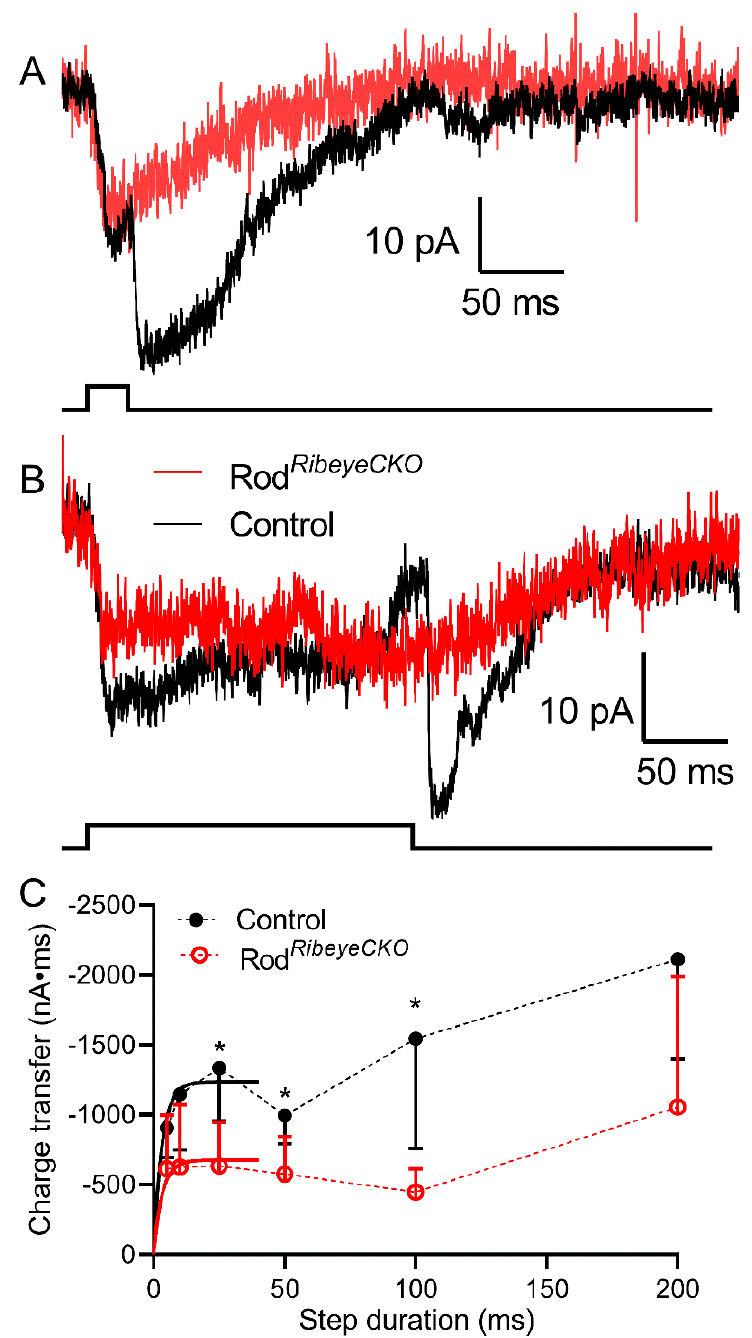
Figure 8. Eliminating rod ribbons halved the releasable vesicle pool. Example recordings of I A(glu) evoked by steps of 10 and 200 ms recorded from a rod in control C57Bl6J (( A ), black traces) and a rod in rod Ribeye CKO retina (( B ), red traces). ( C ). Plot of I A(glu) charge transfer measured the following steps of 5, 10, 25, 50, 100 and 200 ms from rods in the C57Bl6J ( n = 13–34 cells at each data point) and rod Ribeye CKO ( n = 9–18 cells) retinas. The data from 5–25 ms were fit with single exponentials yielding the best-fit amplitude of 1326 and 632 pA*ms in the wild-type and Ribeye CKO rods, respectively. The best-fit time constants were 4.47 and 1.40 ms in the wild-type and Ribeye CKO rods, respectively. These did not differ significantly ( p = 0.44, F-test). Differences between the rods with and without ribbons were significantly different at 25, 50, and 100 ms (*: p <0.05: adjusted p -values, Holm-Sidak method for multiple comparisons, p = 0.0277, 0.0484, and 0.0424,